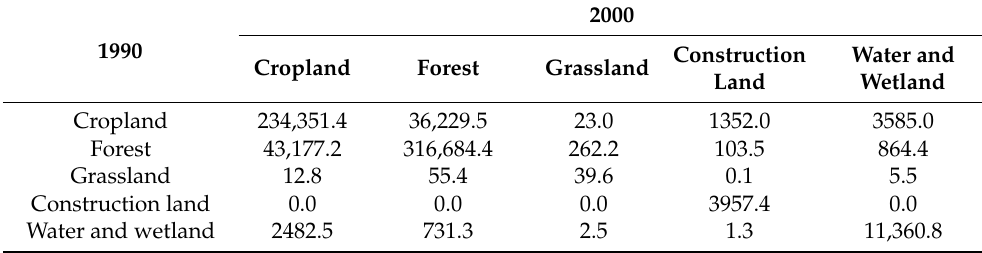
Table A2. The transfer matrix of land-use changes in the Mekong River Basin from 1990 to 2000 (km 2 ).